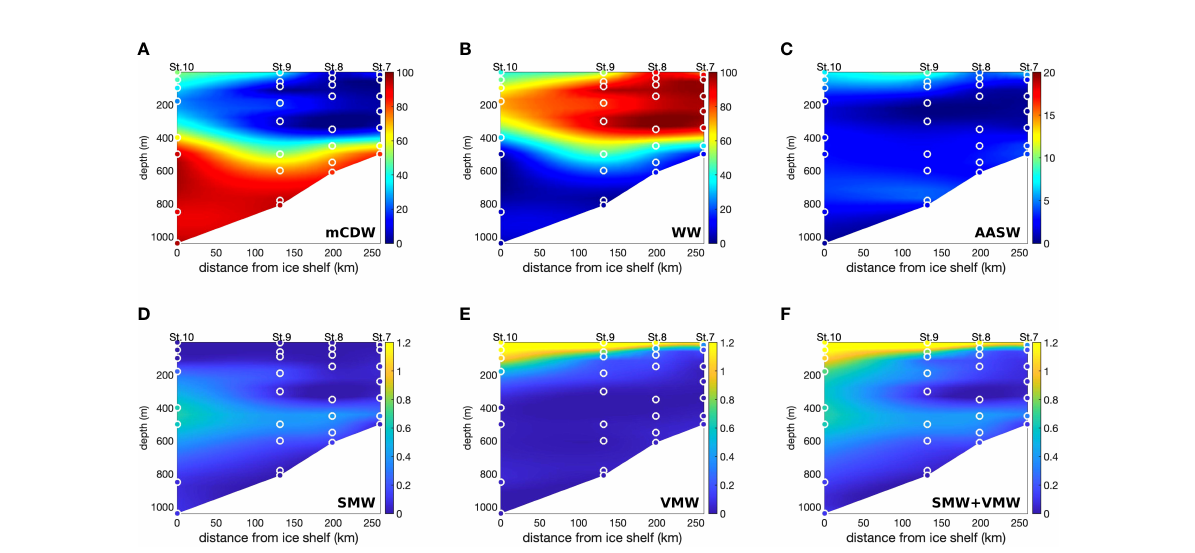
FIGURE 4 Fractional contributions of different source waters (A – F) for the section along the Dotson-Getz Trough calculated by the NG-OMPA. Fractions at the water sample locations (circles) are superimposed on the interpolated values. Five noble gases, in addition to temperature and salinity, were used as tracers for the analysis. The values shown are the averages of 10,000 results produced by Monte Carlo simulation.